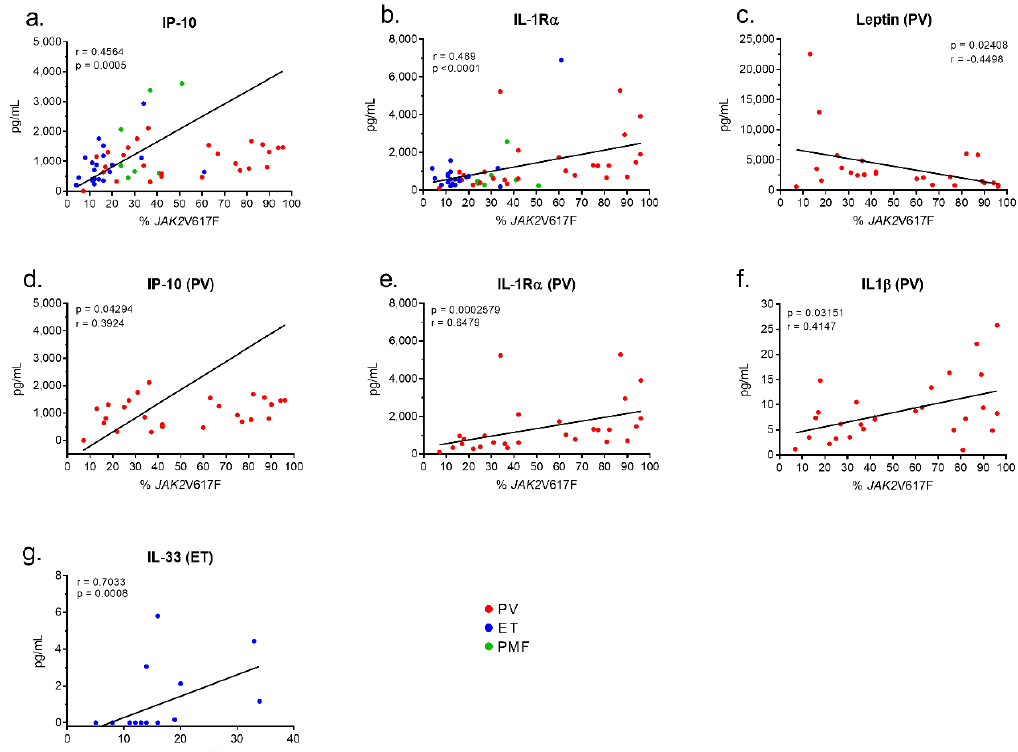
Figure 2. Correlations between cytokine levels and % of JAK2 V617F-mutated alleles. Analysis of the cytokine levels and % JAK2 V617F of the 55 patients with JAK2 V617F-mutated MPN, using Spearman’s t -test, revealed positive correlations between % JAK2 V617F and IP-10 ( a ) and IL-1R α ( b ), and a negative correlation between leptin and % JAK2 V617F, in PV only ( c ). ( d – f ) Positive correlations in PV only between the % JAK2 V617F and IP-10 ( d ), IL-1R α ( e ) and IL-1 β ( f ). ( g ) Positive correlation between IL-33 and % JAK2 V617F in ET only.